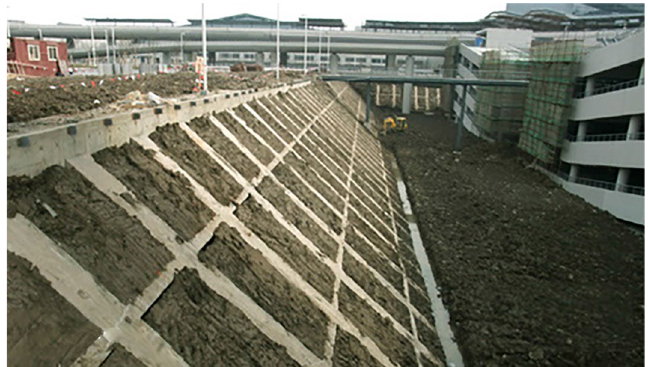
Figure 1. Frame protection of soil slope.